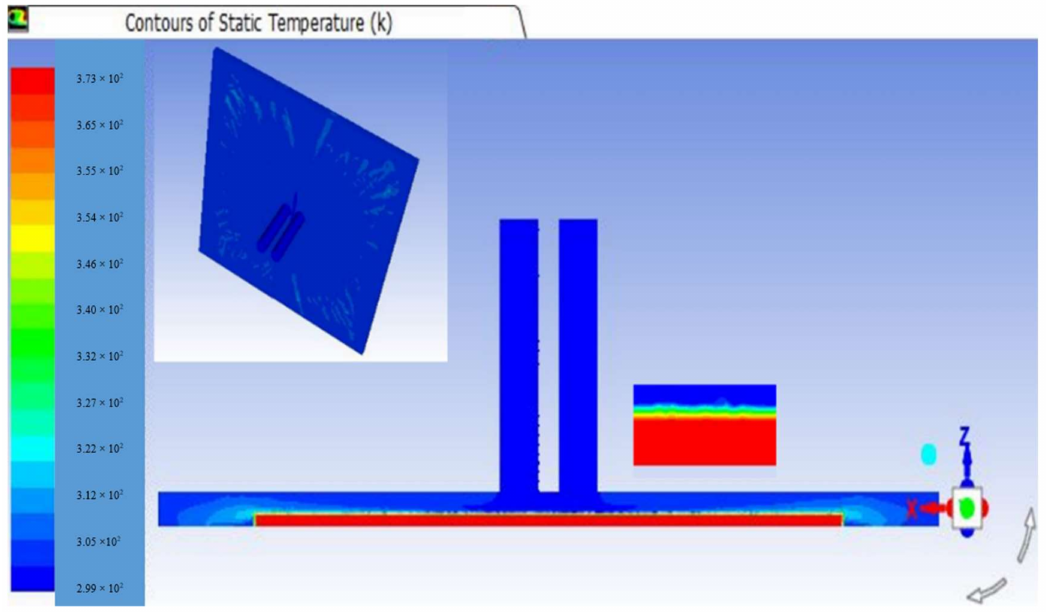
Figure 11. Static temperature contours of the twin jets impingement on the aluminum hot plate at S = 1 cm and H = 1